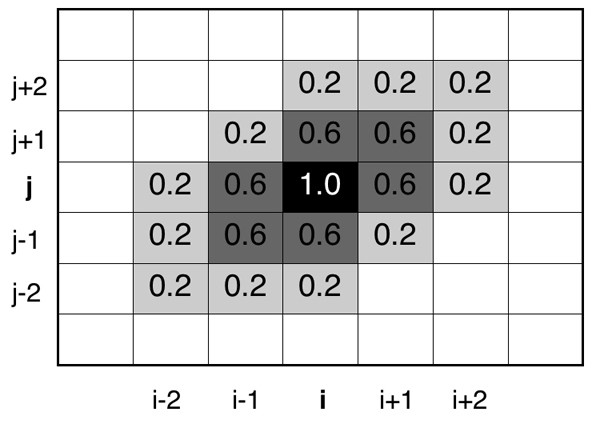
Smoothed inter-residue contacts c(i, j) (Eq. 4). It is presumed that residue pair (i, j) is in contact (i.e., c(i, j) = 1), and that the other pairs are non-contacting. Equation 4 provides negative cs(i', j') at sites where an inequality, |i - i'| + |j - j'| + |(|i - i'| - |j - j'|)| > 5, is satisfied. Besides, this inequality is satisfied without exception when any one of the three inequalities, |i - i'| > 2, |j - j'| > 2, or ||i - i'| - |j - j'|| > 2, is met. Those negative cs(i', j') are reset to zero (see text).